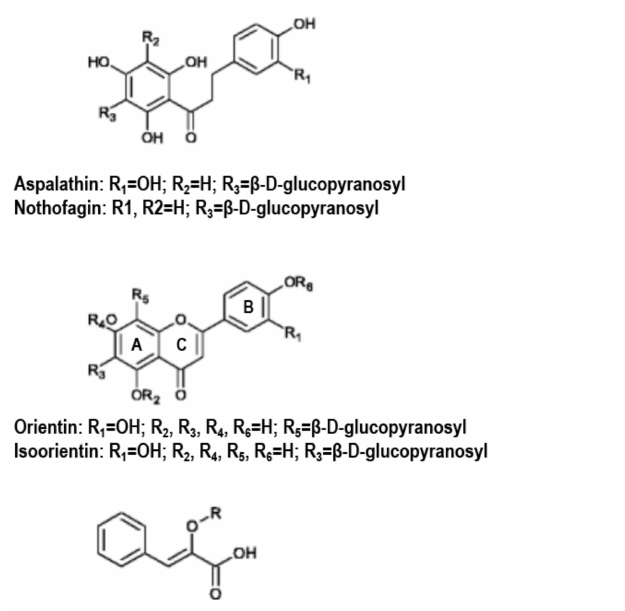
Figure 6. Structures of major flavonoids in rooibos extracts [14] Z-2-( β - D -glucopyranosyloxy)-3- phenylpropenoic acid,